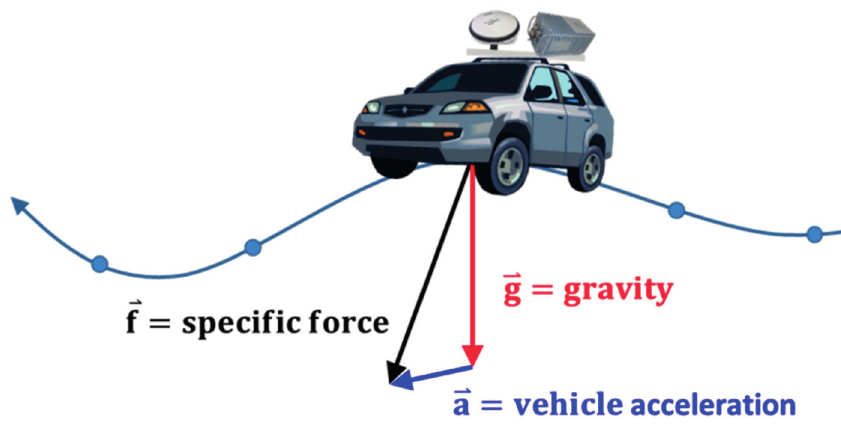
Figure 1. Concept of land-based SINS/GNSS